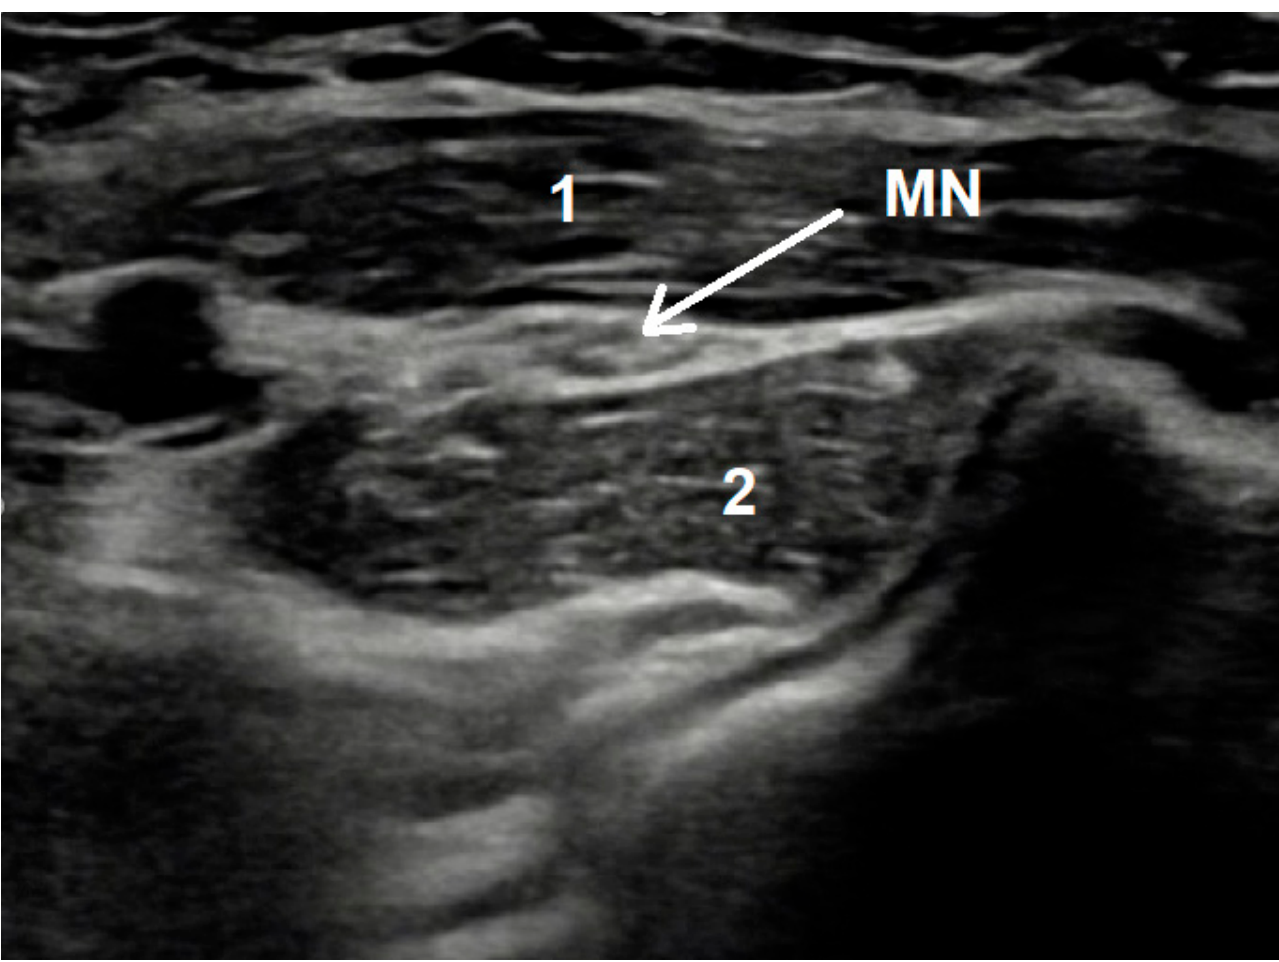
Figure 2. Exemplary image seen during USG examination of pronator syndrome showing medial nerve compression. MN—Medial Nerve; 1—humeral head of Pronator Teres muscle; 2—ulnar head of Pronator Teres muscle; longitudinal cross section Mov. 1 Forearm USG examination result showing median nerve thickening distally to compression site.